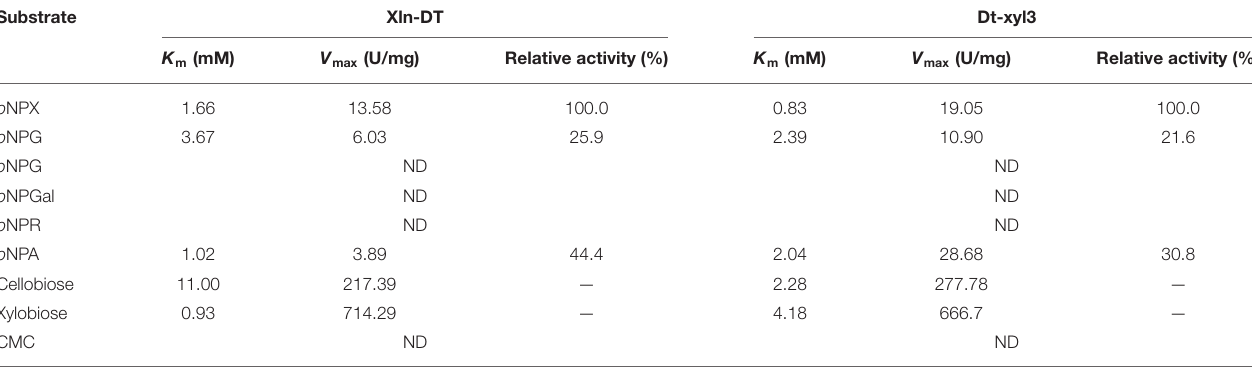
TABLE 3 | Kinetic parameters and specific activities of recombinant Xln-DT and Dt-xyl3.